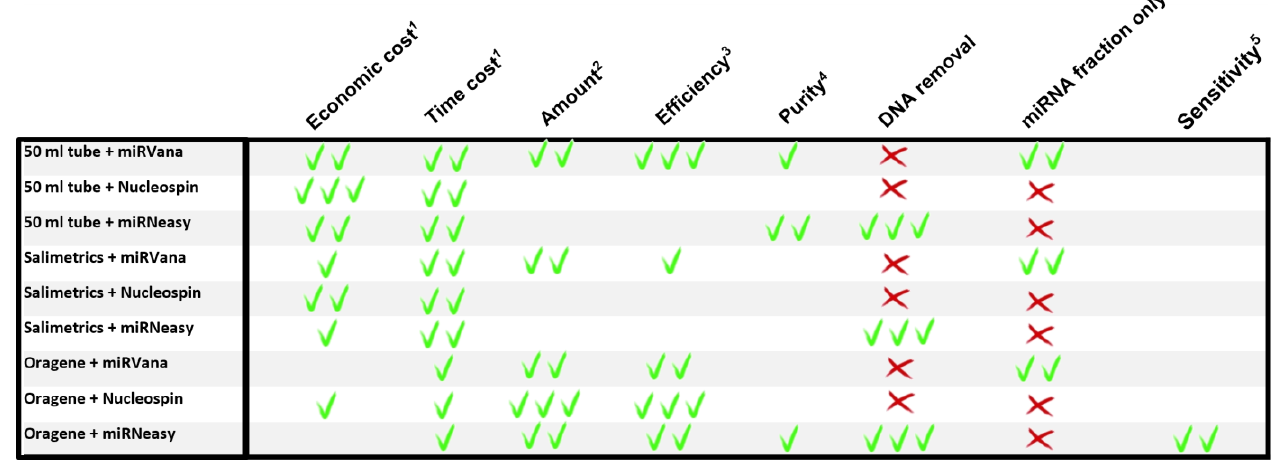
Figure 5. Schematic summary of the different features evaluated. A green tick means achieved; red cross means not achieved. The number of ticks represents the grade of achievement. When referring to the economic cost, one tick represents a more expensive combination than two or three ticks. One tick for time cost represents longer processing times. 1 per miRNA extraction, 2 total RNA amount (ng), 3 ng total RNA/ ul saliva, 4 A260/280, 5 potential of extracting low expressing miRNAs.